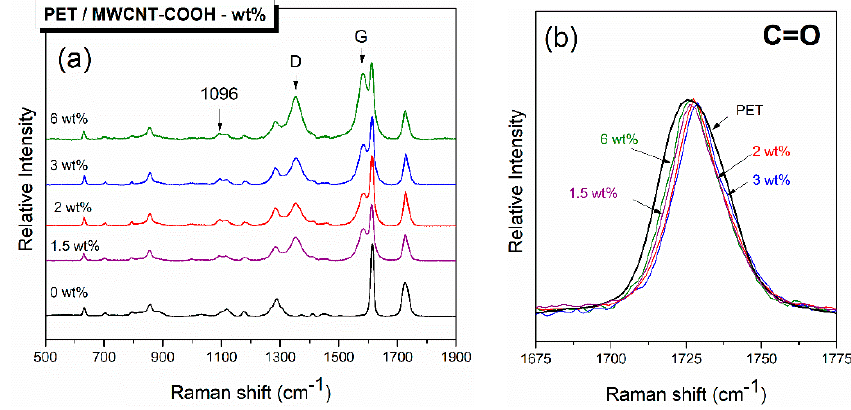
Figure 2. Raman spectra of neat PET and PET / MWCNT composites films ( a ) in the spectral region 500–1900 cm − 1 and ( b ) in the vibrational window of the C = O